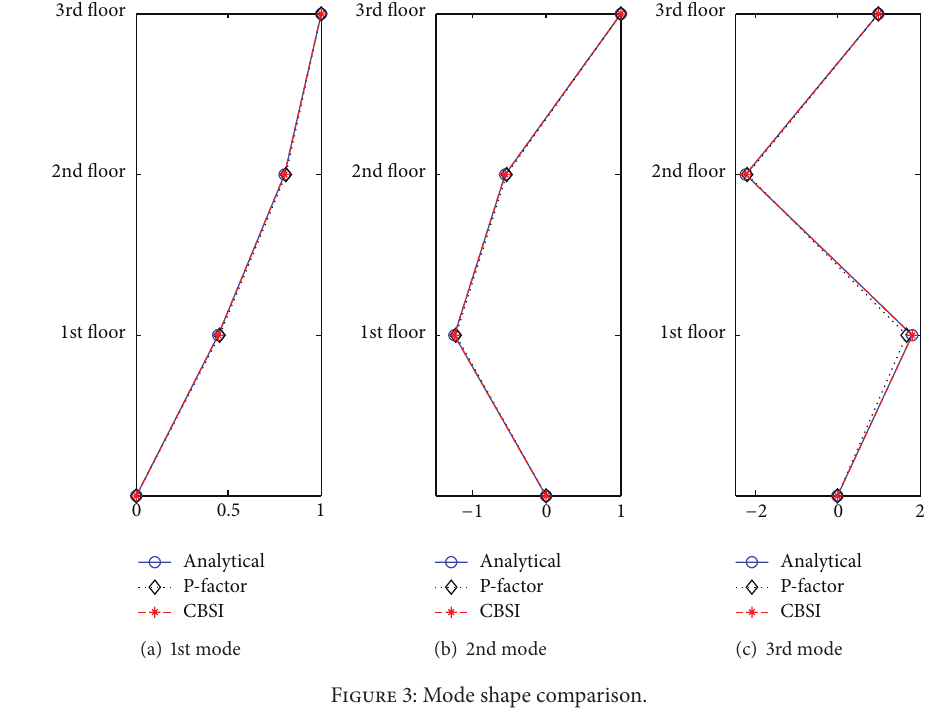
Figure 3: Mode shape comparison.